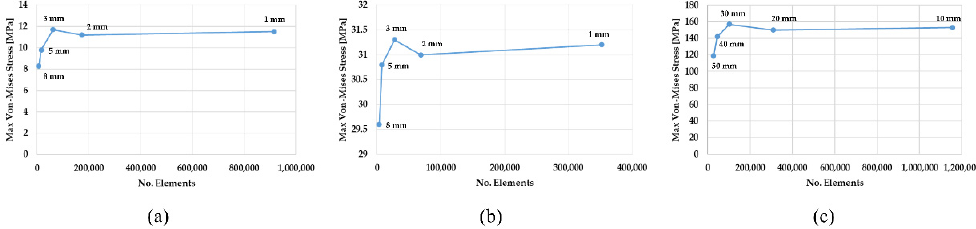
Figure 5. The conducted mesh convergence studies: ( a ) bell crank lever, ( b ) pillow bracket, and ( c ) small bridge.